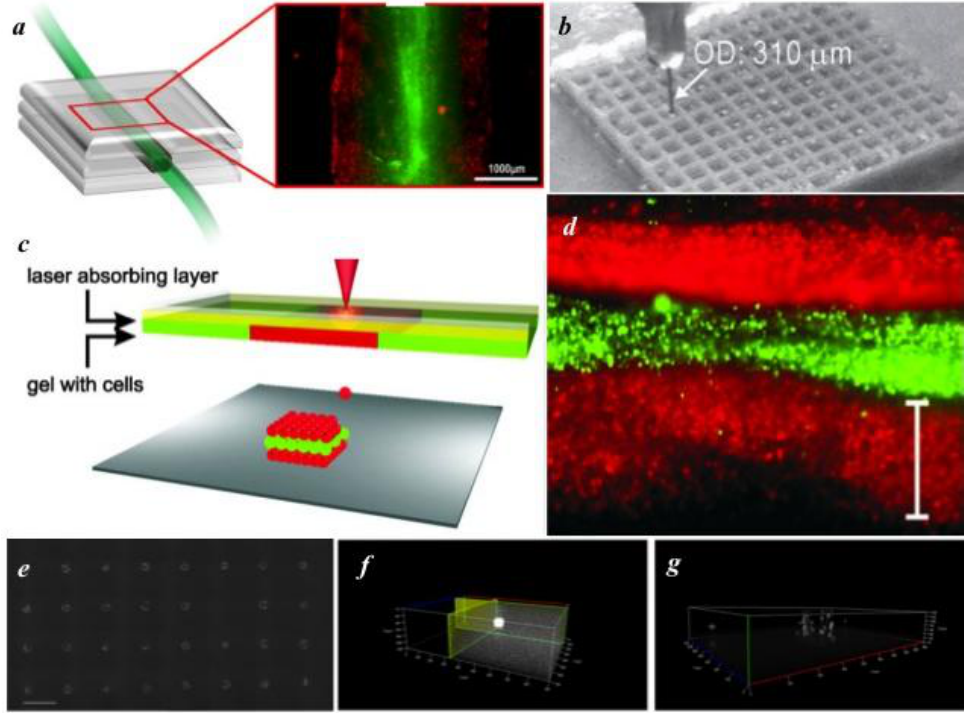
Figure 3. Examples of 3D patterned structures with future biosensing